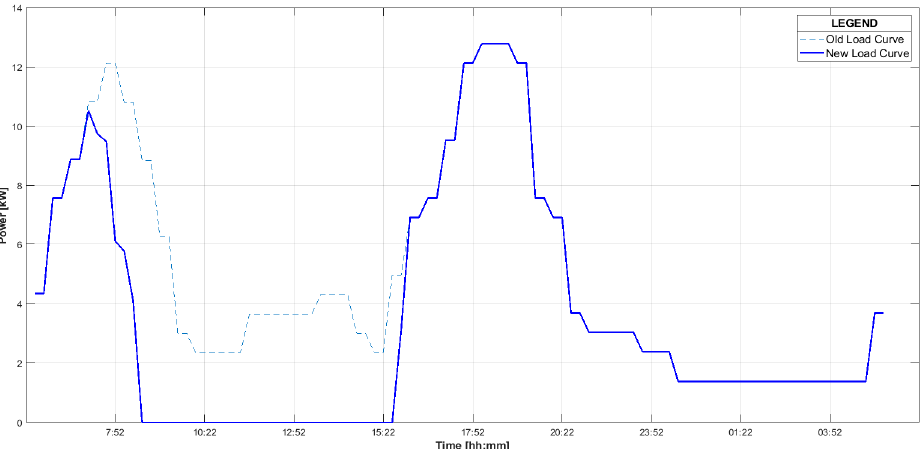
Figure 17. Comparison between the old load curve and the new one.